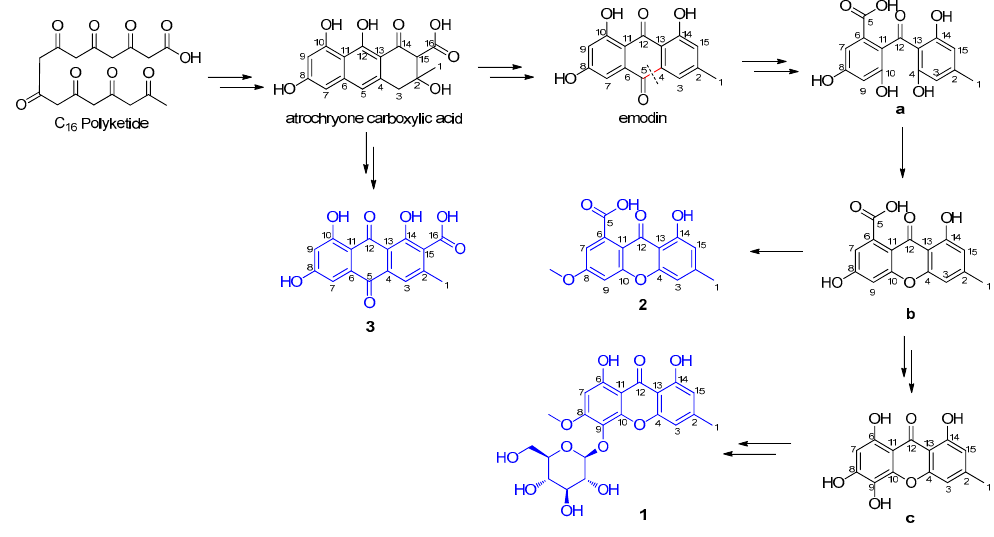
*: The assignment maybe